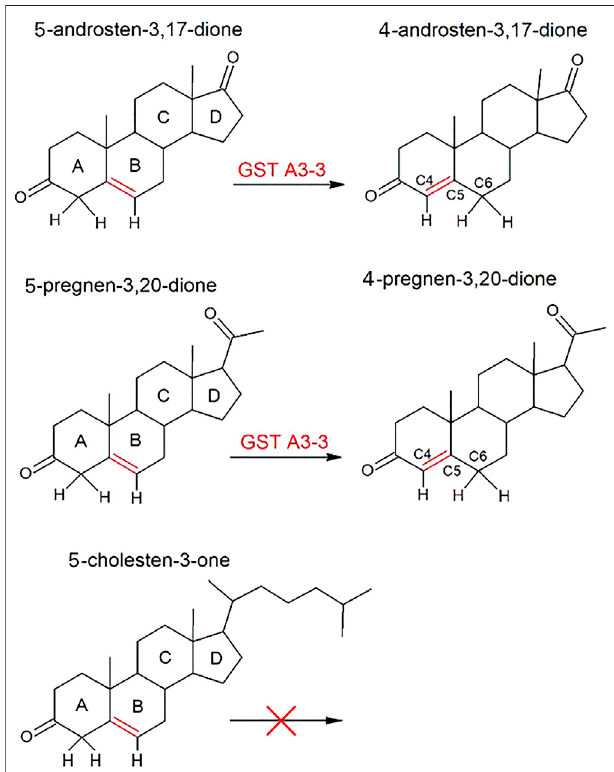
FIGURE 2 | Double-bond isomerization of 5-androsten-3,17-dione and 5-pregnen-3,20-dione catalyzed by GST A3-3 and other ketosteroid isomerases. The structurally related 5-cholesten-3-one is not a